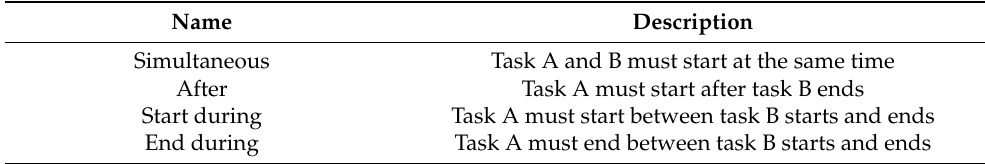
Table 8. Temporal coupled constraints in centralized TACTAR.